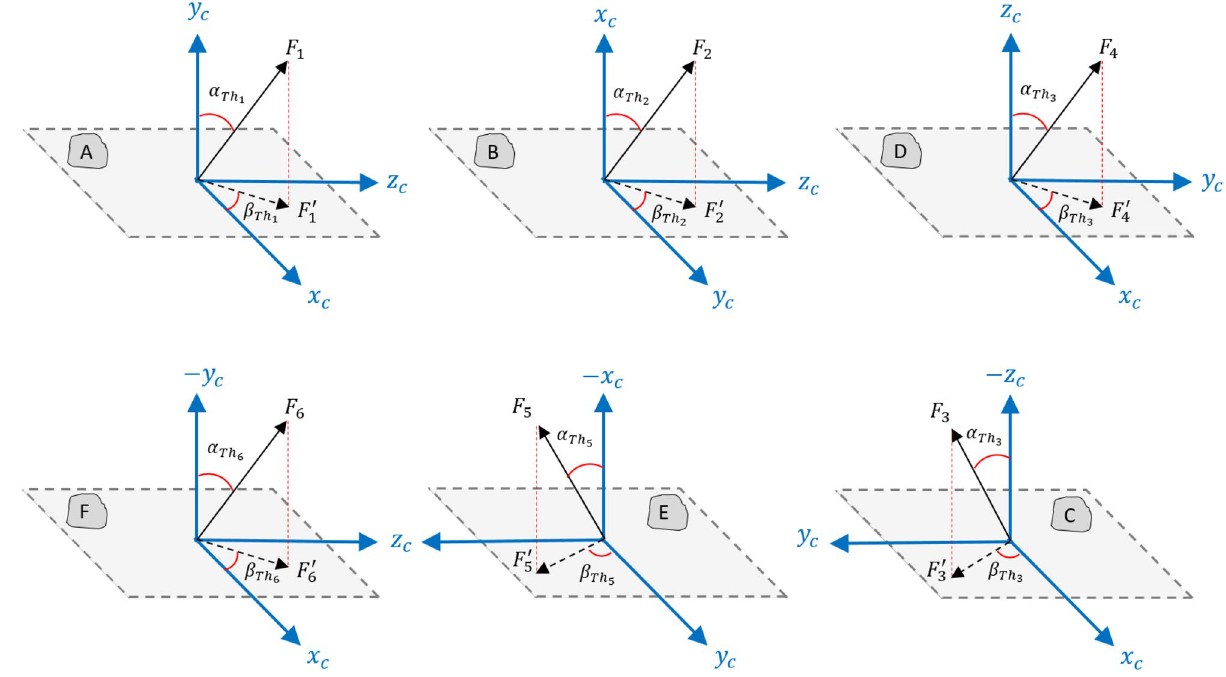
Figure 11. Thrust vector misalignment.